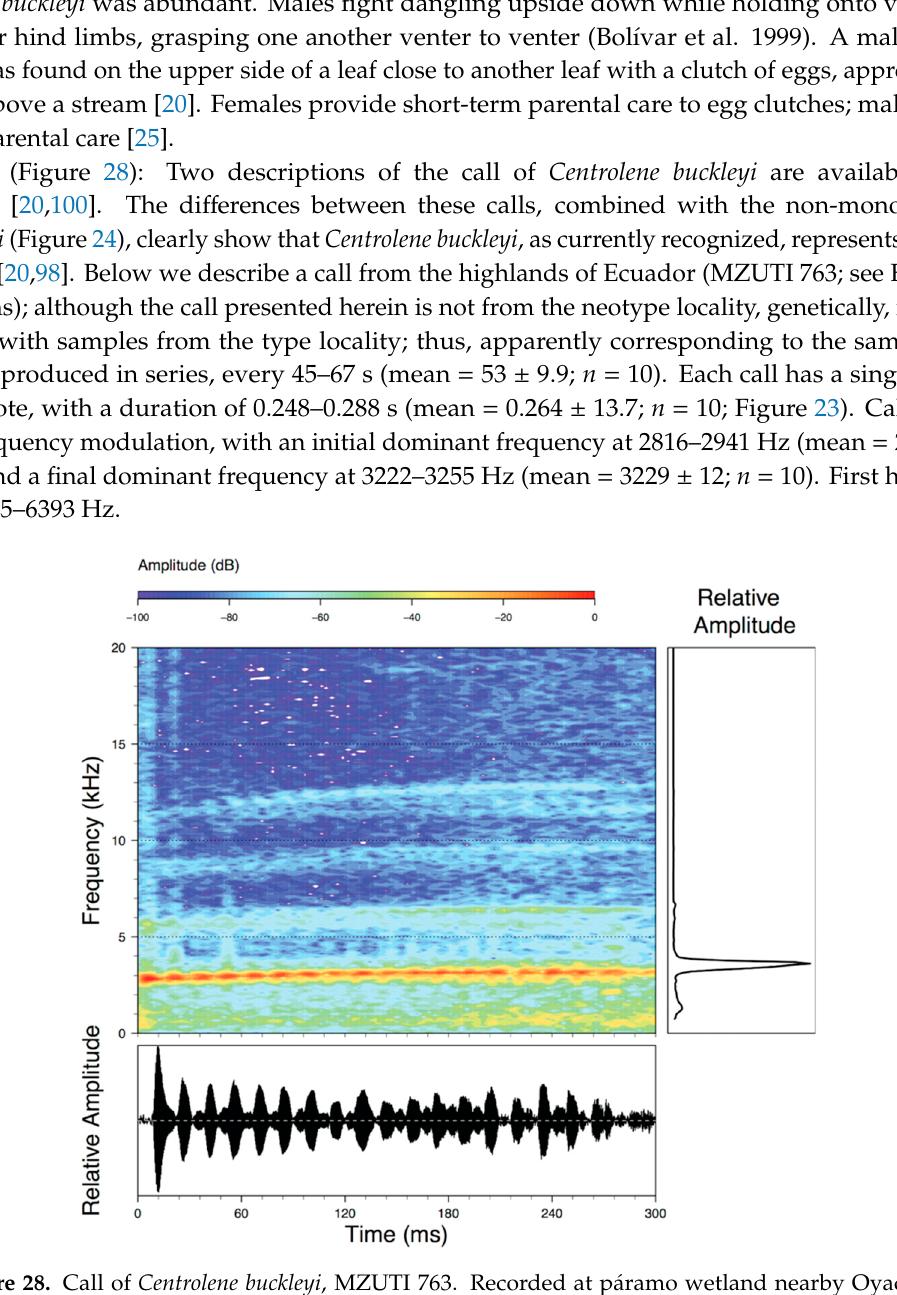
Figure 28. Call of Centrolene buckleyi , MZUTI 763. Recorded at páramo wetland nearby Oyacachi, 3012 m, Napo province, Ecuador.